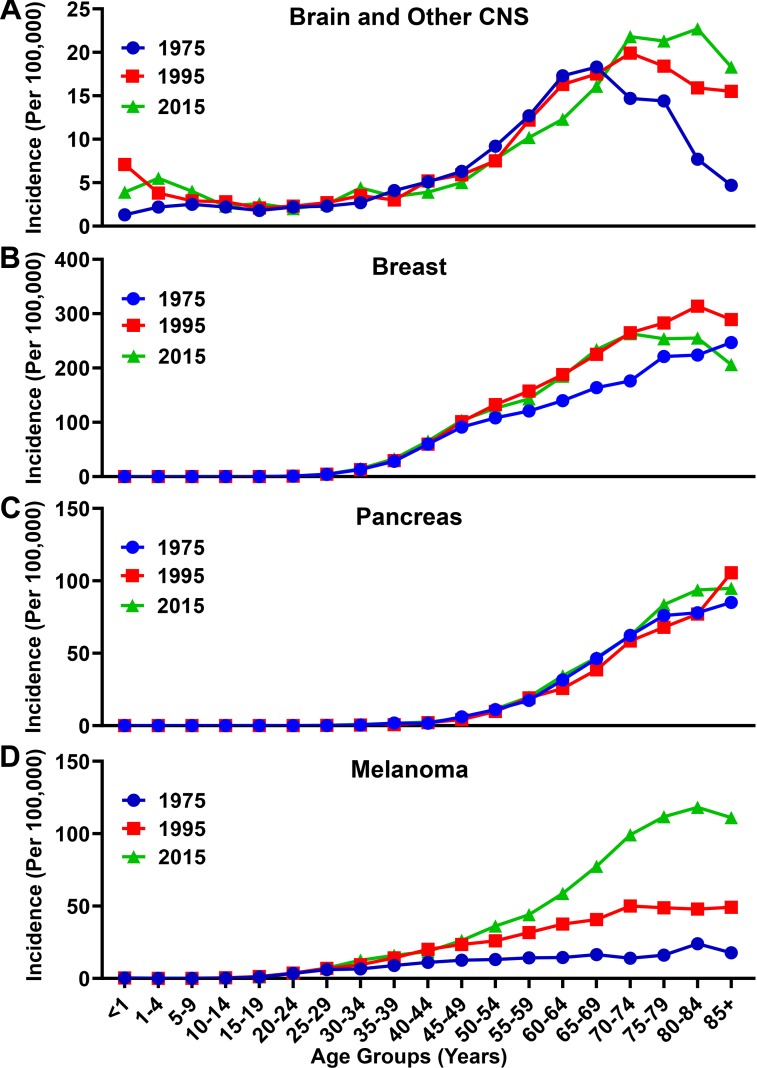
Incidence rate for brain, breast, pancreatic, and melanoma malignancies over time. Incidence rates for (A) brain and other CNS, (B) breast, (C) pancreatic, and (D) melanoma malignancies analyzed from the SEER database for the years 1975, 1995, and 2015. Rates defined as number of cases divided by the population in each age category multiplied by 100,000 people (per 100,000).